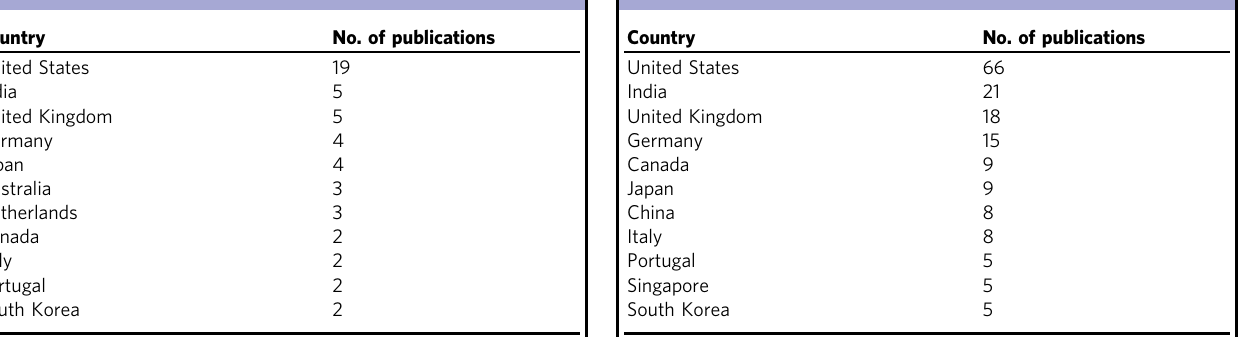
Table 3 Top countries of origin of the articles from the computer science area (CS).